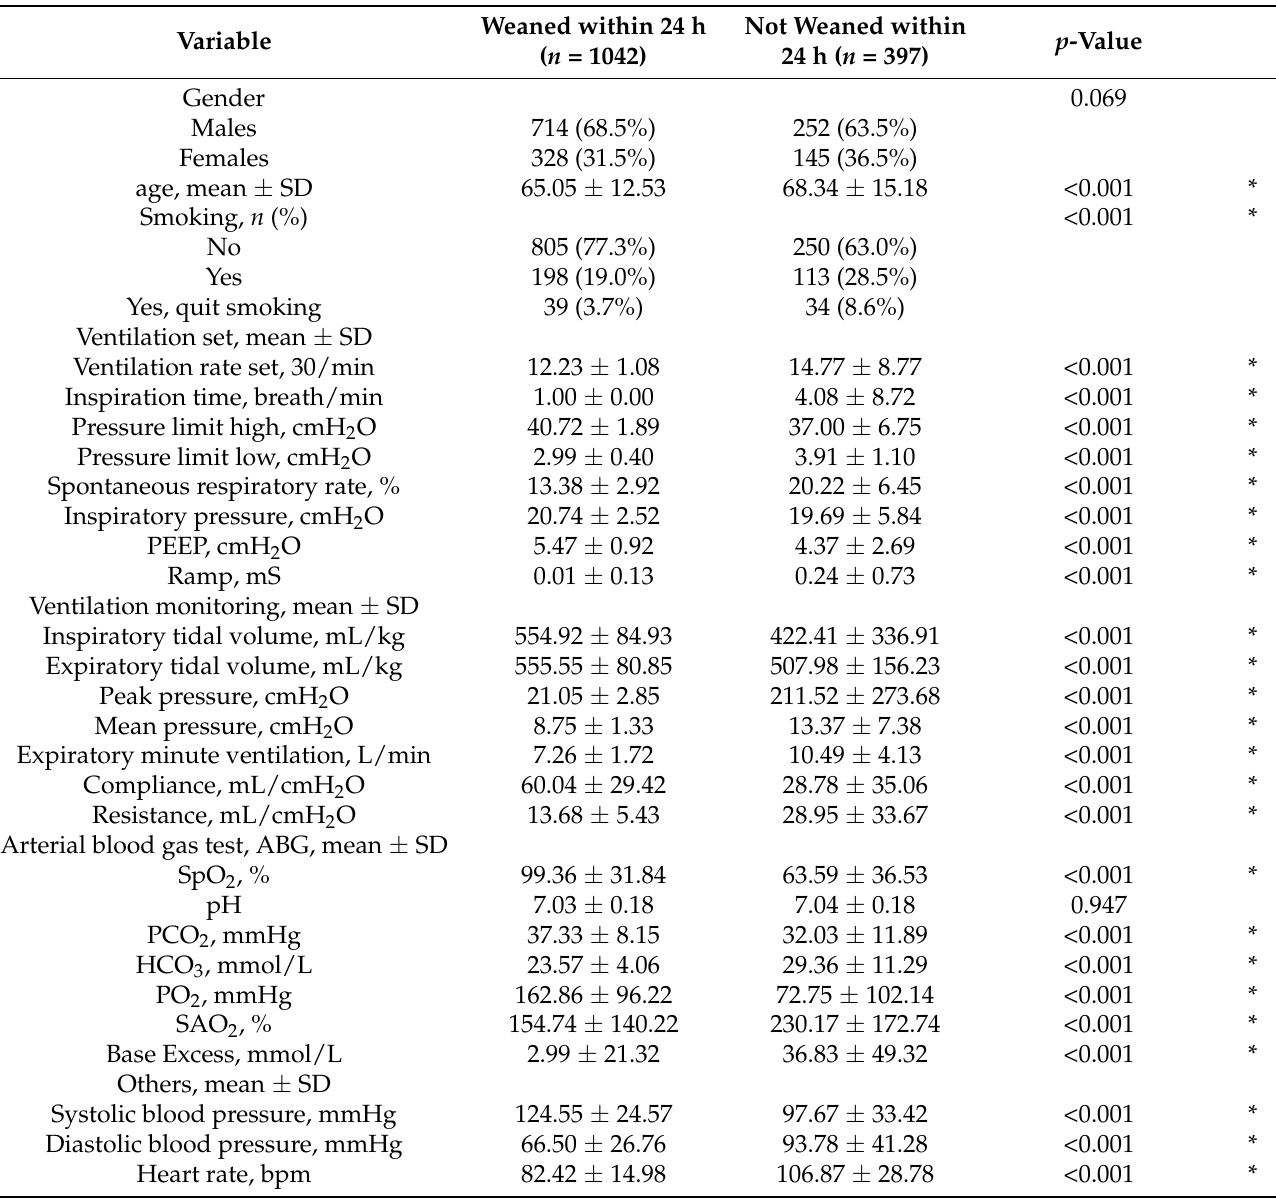
Table 1. Demographic and clinical characteristics of 1439 cardiac intensive care unit patients with planned